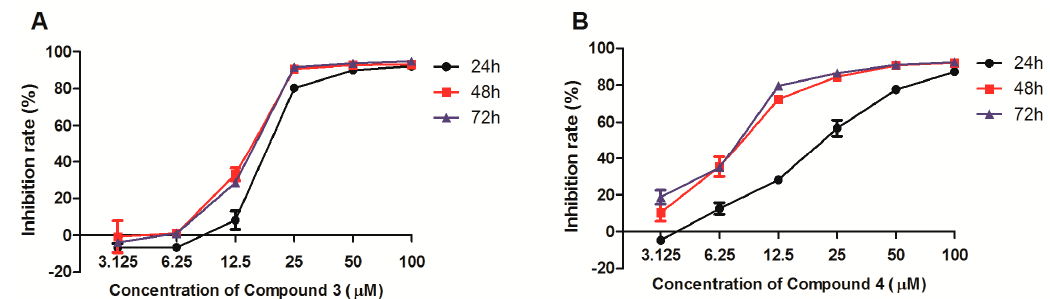
Figure 2. Effects of compounds 3 ( A ) and 4 ( B ) on viability of HeLa cell at different concentrations for different incubation time. HeLa cells were incubated with compound 3 or 4 at the concentration of 3.1 μ M to 100 μ M, and then the cytotoxic activity was evaluated using the 3-(4,5-dimethylthiazol-2-yl)-2,5-diphenyltetrazolium bromide (MTT) assay at 24 h, 48 h, and 72 h, respectively. The values are expressed as mean ± SD of triplicate experiments.